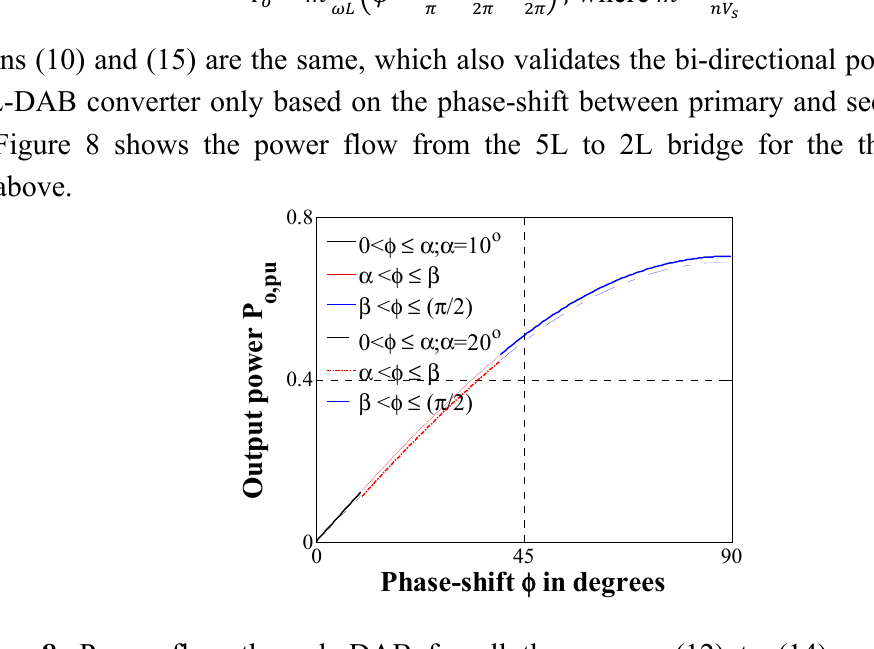
Figure 8. Power flow through DAB for all three cases (12) to (14), with respect to phase-shift (cid:2038) ; here, (cid:2009) = 10 (cid:2868) and 20 (cid:2868) , (cid:2010) = 40 (cid:2868) are assumed for